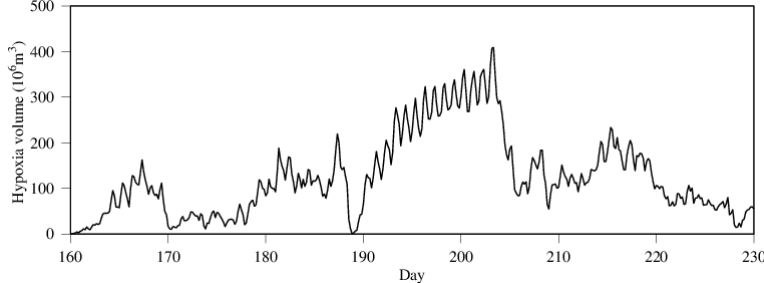
Figure 6. Time ‐ series of hypoxia volume in 2004 (low hypoxia year) and 2005 and 2006 (high hypoxia years). Figure 7. Diurnal variability in hypoxia volume in summer 2005. Figure 7. Diurnal variability in hypoxia volume in summer Figure 7. Diurnal variability in hypoxia volume in summer 2005.